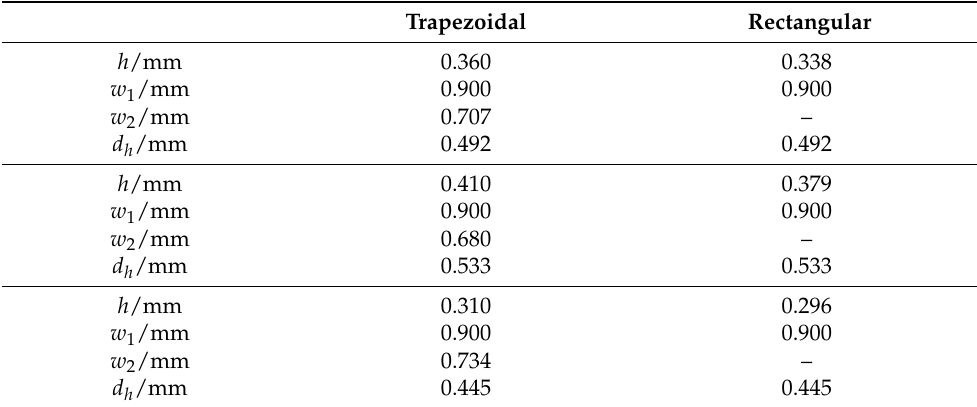
Table 3. Channel dimensions for the CFD simulation with a variation of ± 0.05mm in depth. For the parameters, see Figure 8. Trapezoidal Rectangular h